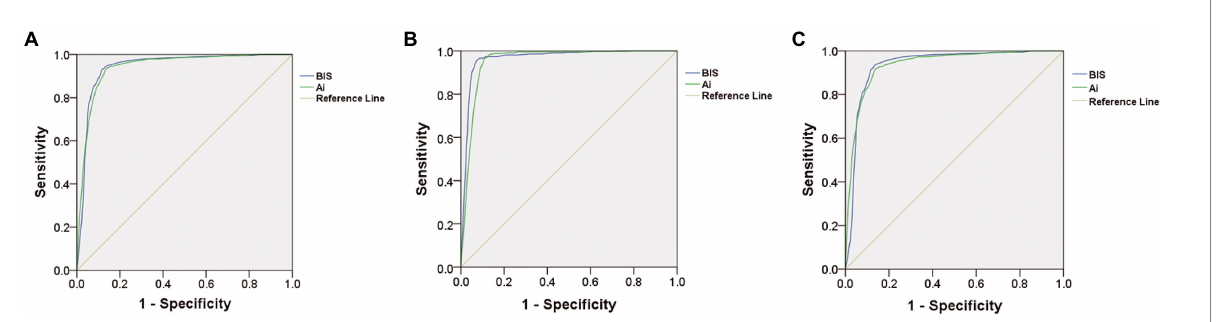
FIGURE 4 Comparison of receiver operating characteristic curve showing the accuracy in judging the anesthesia-induced unconsciousness (A) , LOC (B) , or ROC (C) between Ai and BIS.